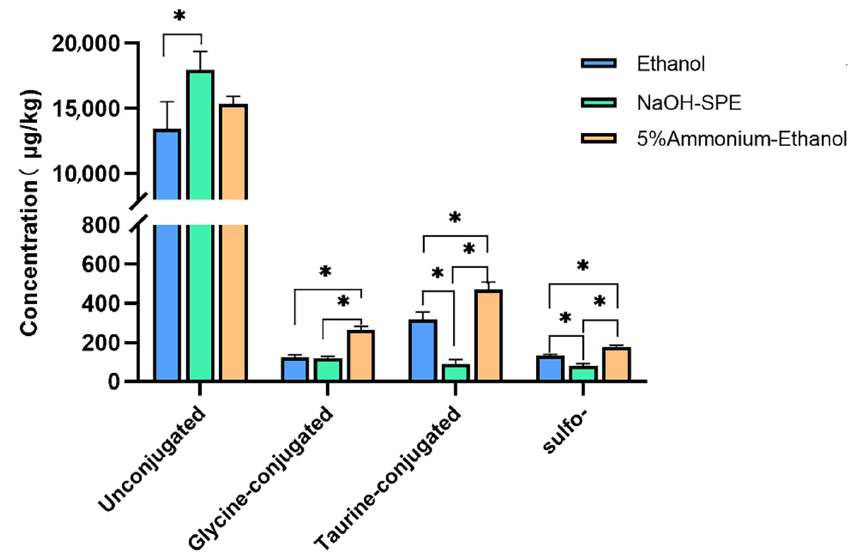
Figure 1. Extraction conditions comparison of bile acids profiles. Differences considered significant ( p < 0.05) are denoted by *.